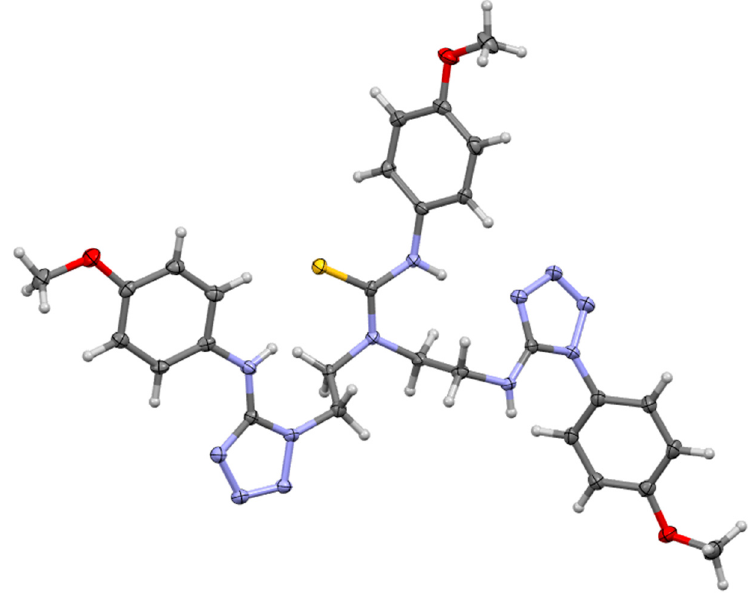
Figure 4. The molecular structure of 3-(4-methoxyphenyl)-1,1-bis(2-{[1-(4-methoxyphenyl)-1H-tetrazol-5-yl]amino}ethyl)thiourea ( 7 ) showing atom numbering and displacement ellipsoids at the 50% probability level.